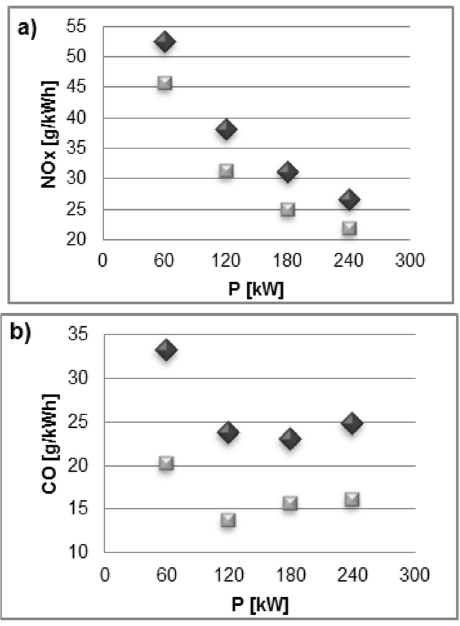
Fig. 3. The results of a) NO , b) CO emissions: – engine assumed as x operated without malfunctions, – the delay of the fuel injection